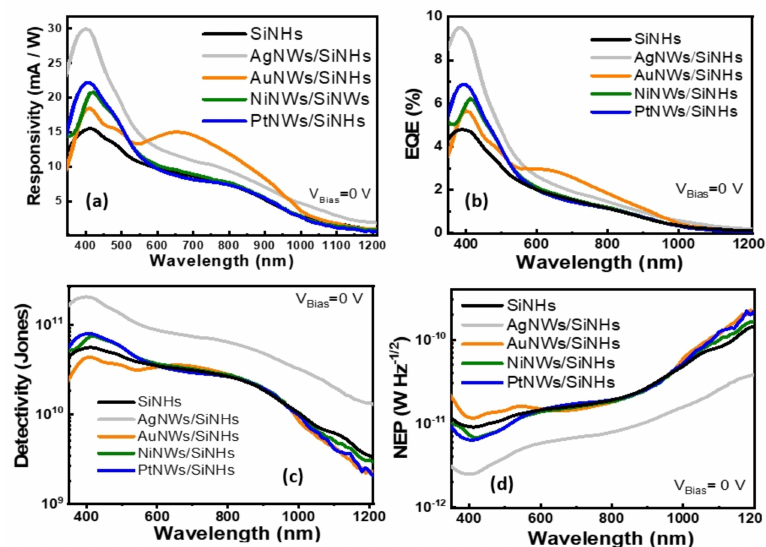
Figure 7. ( a ) Wavelength-dependent responsivity spectra; ( b ) external quantum efficiency spectra; ( c ) specific detectivity spectra and ( d ) noise-equivalent power (NEP) of MeNWs/SiNHs-based photodetectors under self-biased